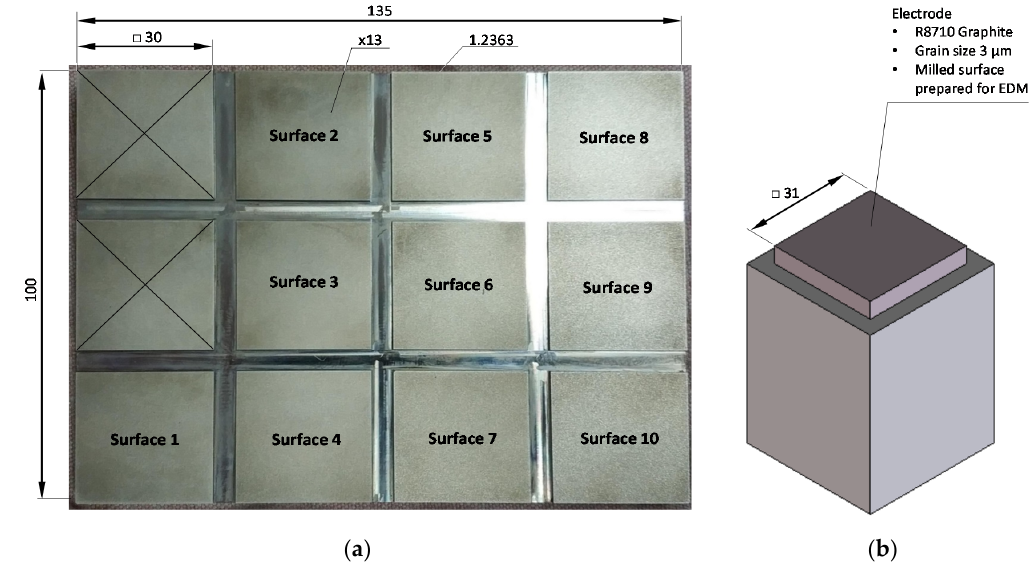
Figure 1. Materials prepared for the study: ( a ) 52 HRC workpiece made of 1.2363 steel as machined; ( b ) graphite electrode with 3 µm grain size.